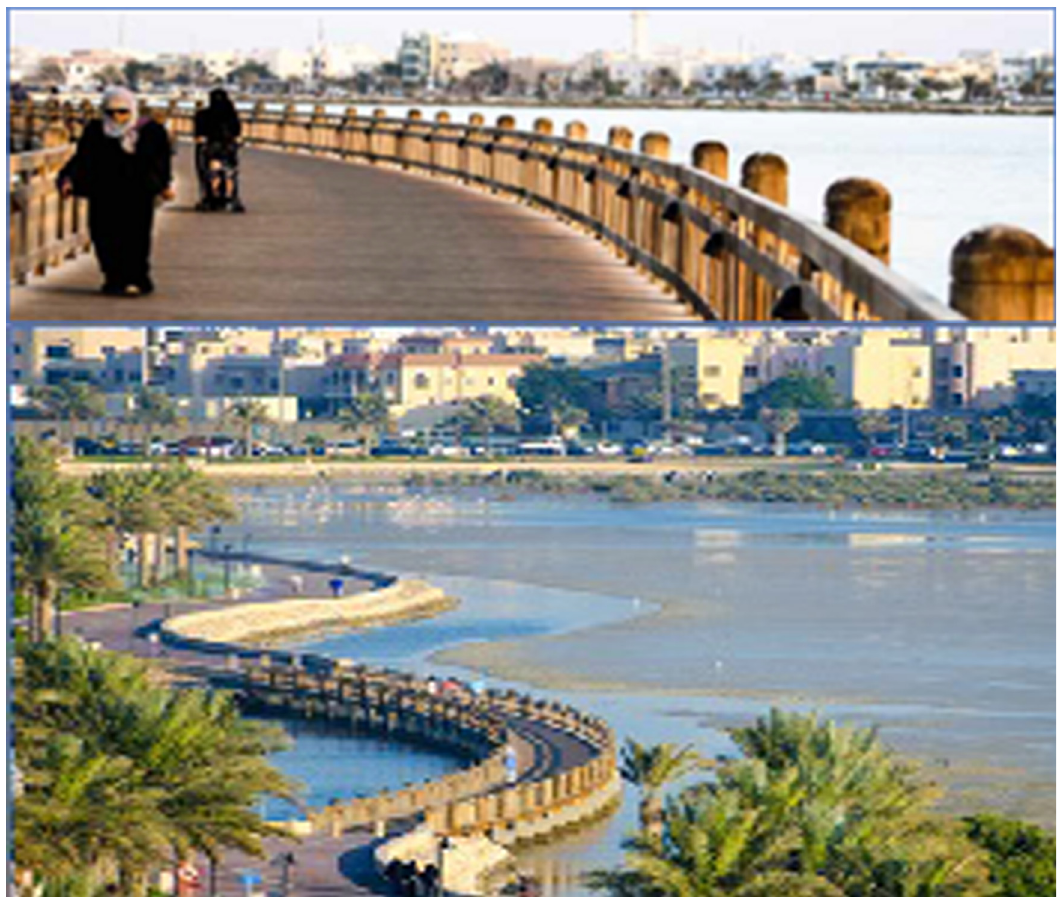
Fig. 3. One of the best-practiced projects that was developed is the Protectorate Areas. This project was the Bronze winner Prize in the LivCom Community Competition in China 2013.